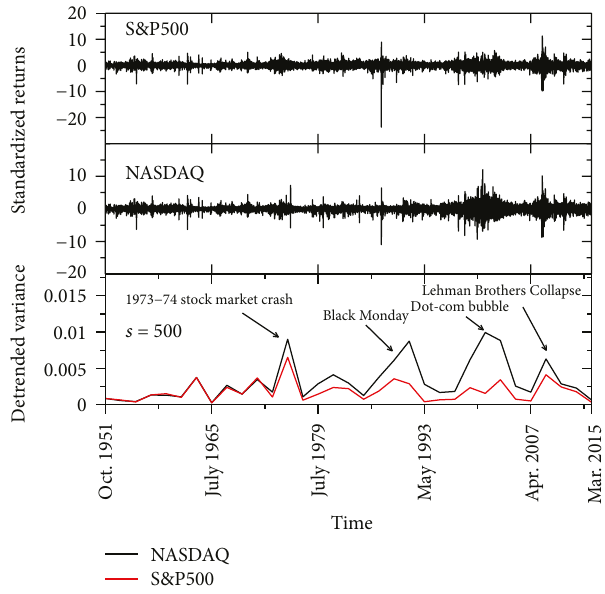
Figure 6: Two upper panels: daily returns for the S&P500 and for the NASDAQ over the period January 03, 1950 – December 29, 2016. The bottom panel: the corresponding detrended variance for the S&P500 (red line) and for the NASDAQ (black